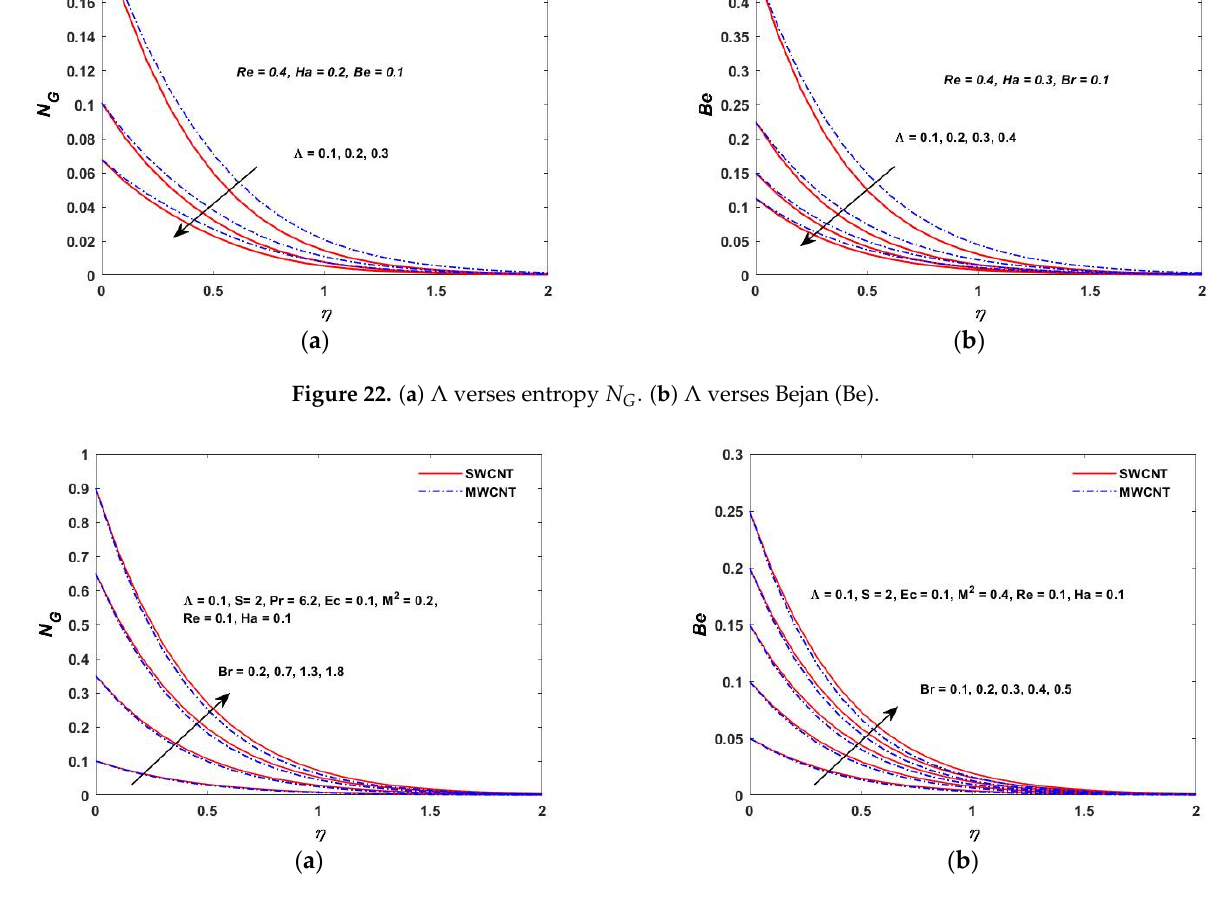
Figure 23. ( a ) Brickman verses entropy 𝑁 (cid:3008) . ( b ) Brickman verses Bejan (Be).